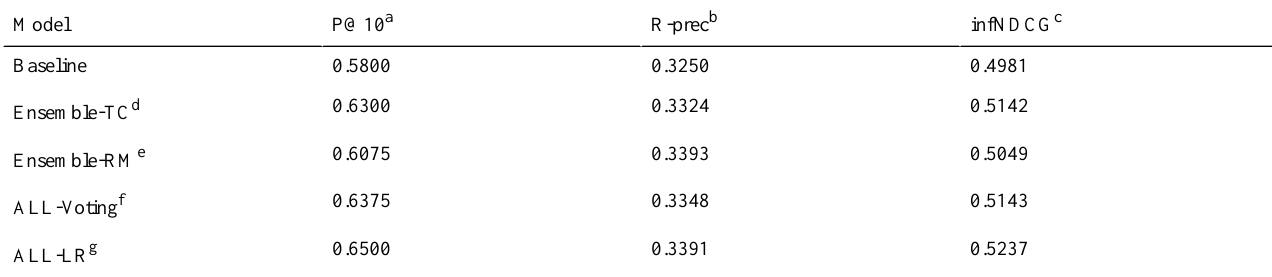
Table 4. Ensemble experiment results.